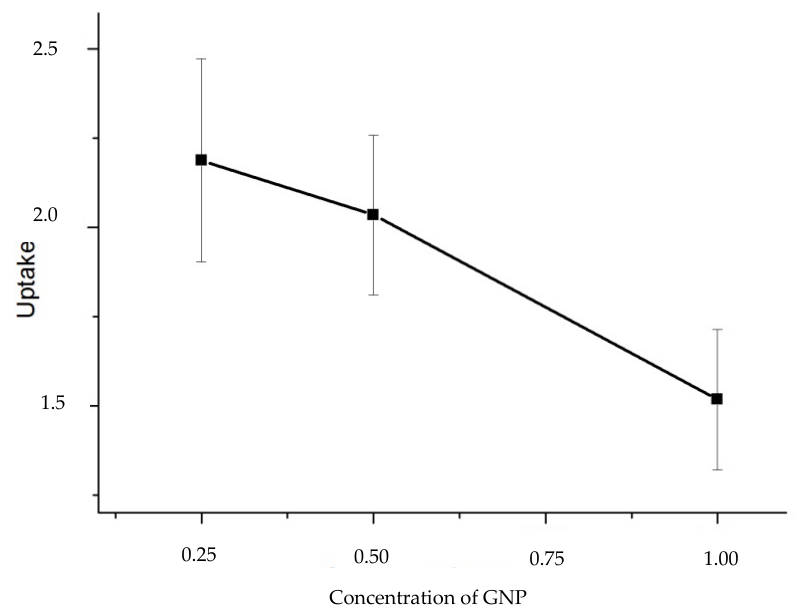
Figure 17. Uptake at day 31 of aging as a function of the amount of GNP present in composites.